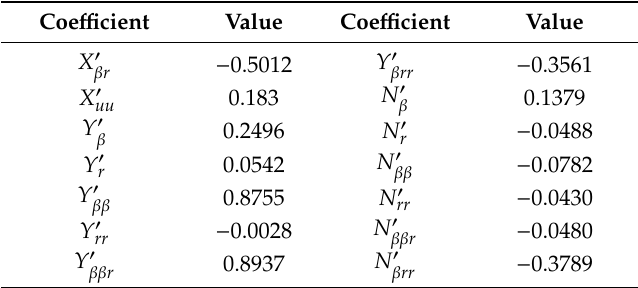
Table 2. Ship hydrodynamic coe ffi